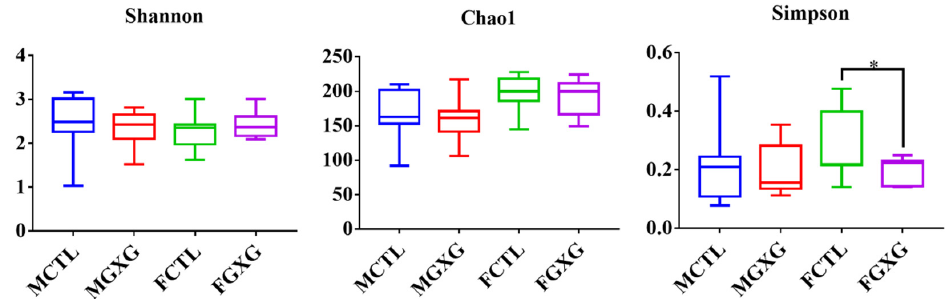
Figure 1. Effect of Dendrobium officinale polysaccharides on the α -diversity of microbiota. * means p < 0.05. p < 0.05.